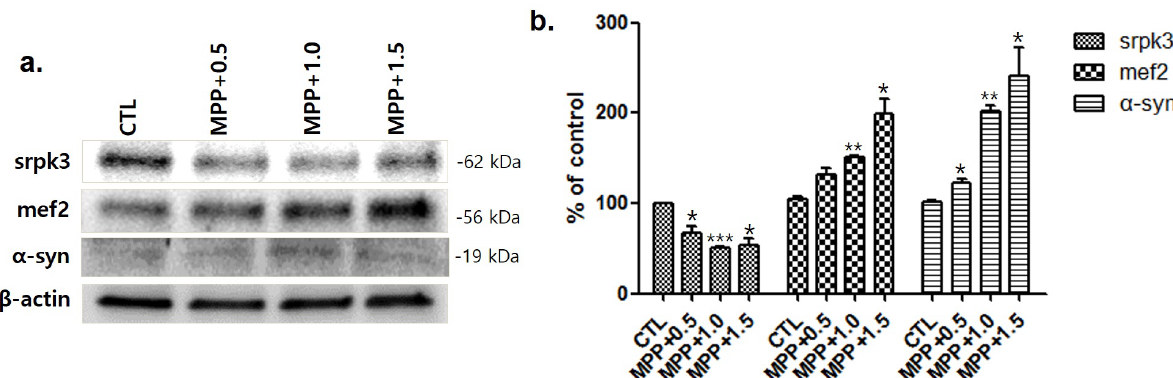
Figure 5. Western blot analysis of components linked to serine/arginine-rich protein specific kinase 3 ( srpk3 ) at different 1-methyl-4-phenylpyridinium (MPP+) concentrations in C2C12 cells. ( a ) Western blot analysis of srpk3 , mef2, and α -synuclein ( α -syn) at different MPP+ concentrations treated: 0.5, 1.0, and 1.5 mM. MPP+ was applied for 18 h. ( b ) Quantified protein levels of the Western blot results ( n = 3). (* p < 0.05, ** p < 0.01, and *** p < 0.005 were compared to control).